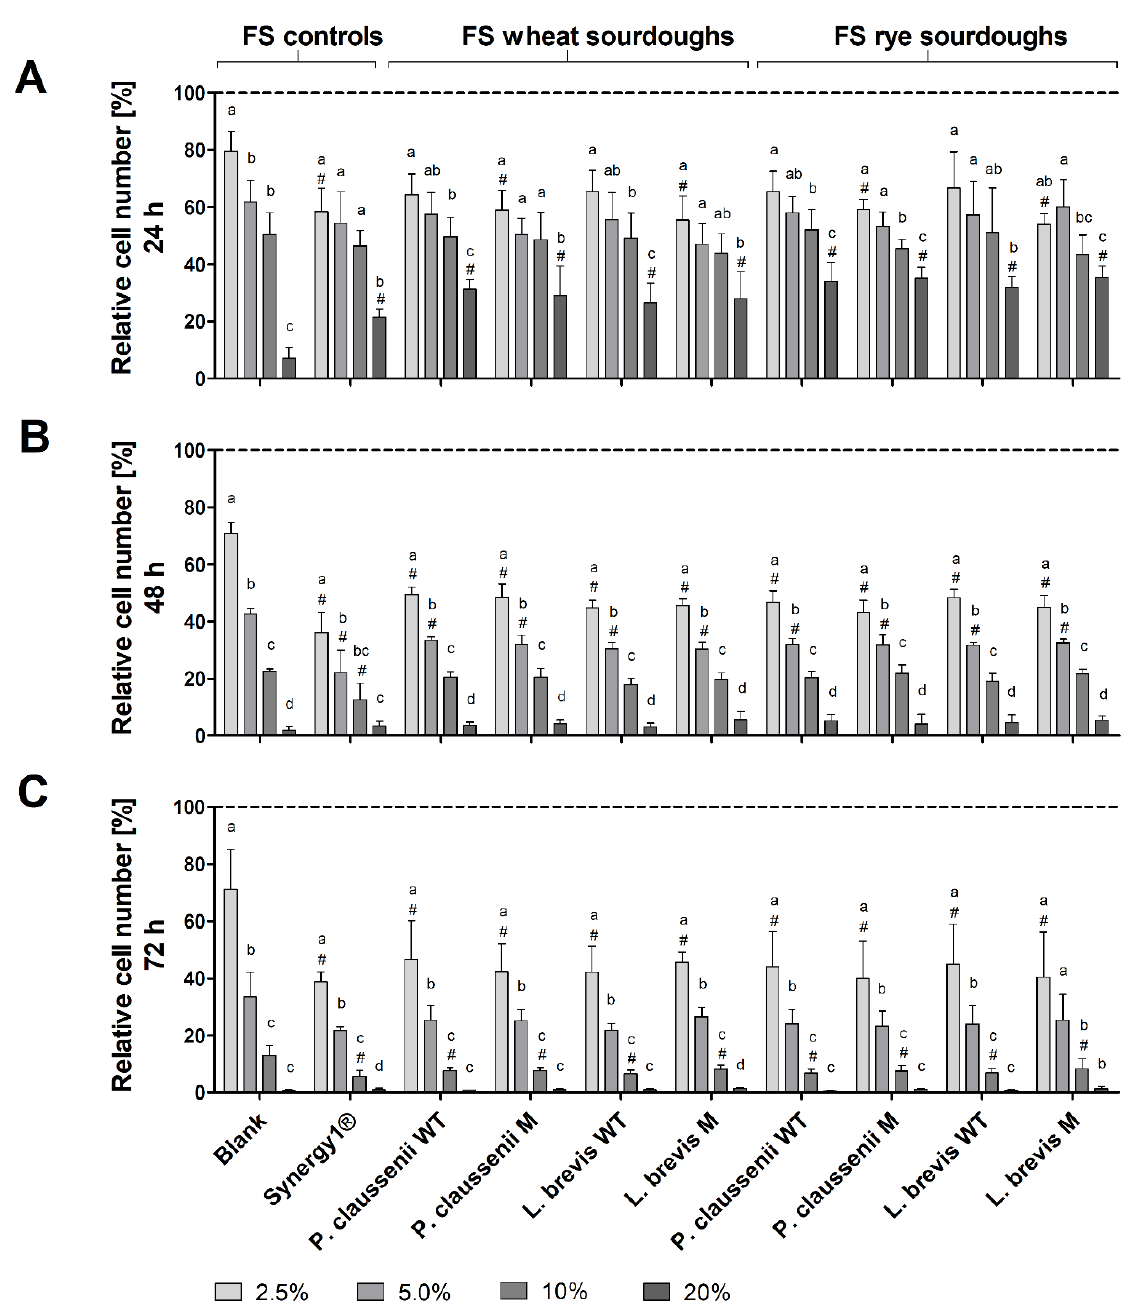
Figure 3. Relative number [%] of LT97 colon adenoma cells after treatment with different concen- trations (2.5%, 5%, 10% and 20%) of fermentation supernatants (FS) obtained from controls (blank, Synergy1 ® ) and wheat and rye sourdoughs for 24 h ( A ), 48 h ( B ) and 72 h ( C ). Sourdoughs were generated using wild-type (WT) and mutant (M) strains of Pediococcus claussenii (WT: TMW 2.340, M: TMW 2.2123) and Levilactobacillus brevis (WT: TMW 1.2112, M: TMW 1.2320). Results were cal- culated on the basis of the medium control (dashed line), which was set at 100% (mean + SD, n = 4). Significant differences between cells treated with FS blank and cells treated with FS of all other samples ( # p < 0.05) and significant differences between cells treated with different concentrations of FS ( a–d p < 0.05, different letters represent significantly different results) were obtained by one-way ANOVA and F-test according to Ryan–Einot–Gabriel–Welsh. TMW: Technische Mikrobiologie Wei- henstephan.